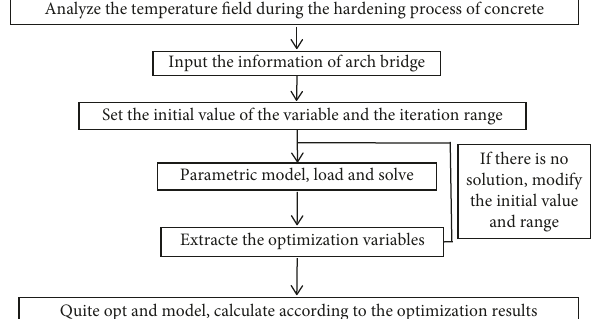
Figure 20: The optimization algorithm of perfusion-time interval.